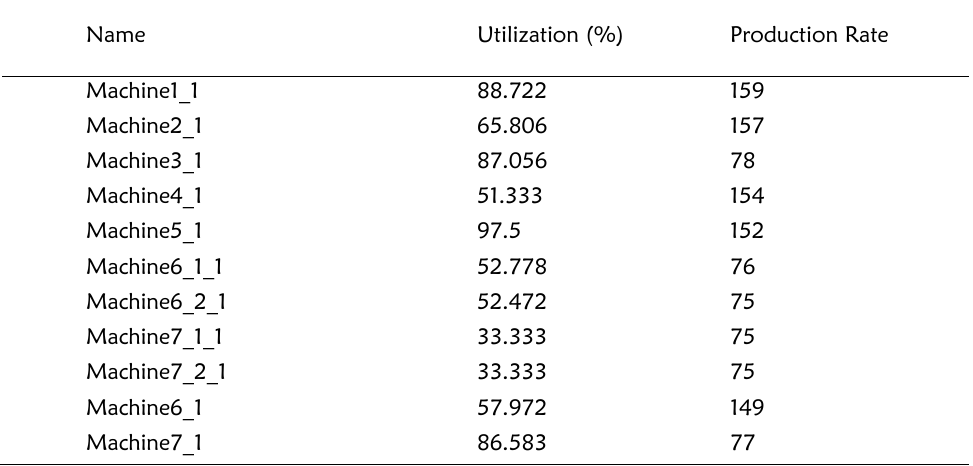
Table 5: Utilization and production rate for the proposed system (Fig. 7)